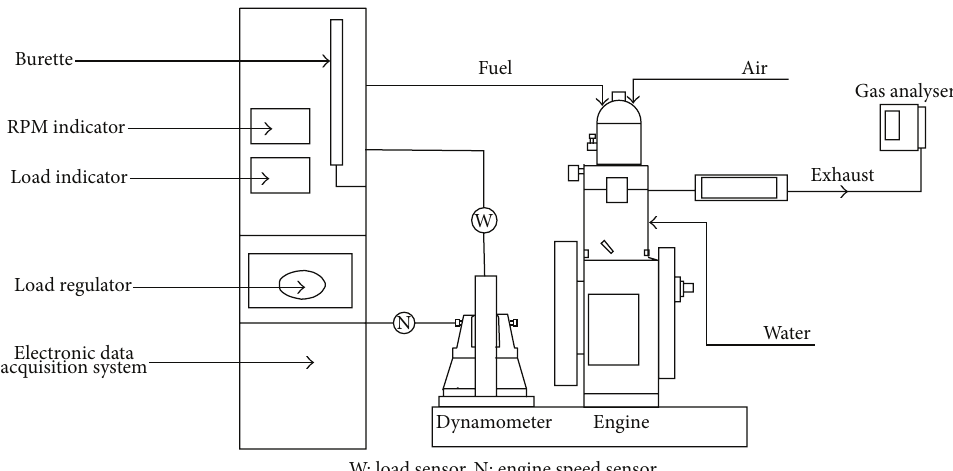
Figure 1: Schematic diagram of experimental setup.